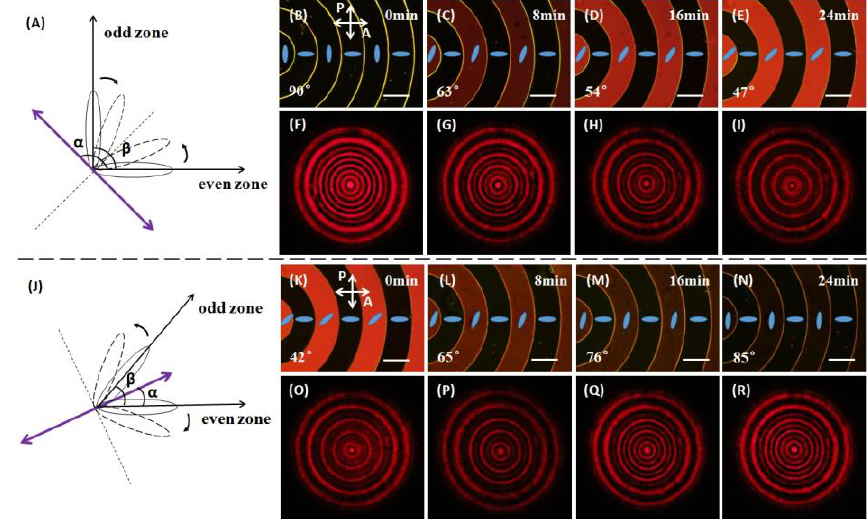
Figure 3. Schematic diagrams of the optical tuning process, and micrographs under polarizing optical microscope (POM) with two crossed polarizers and diffraction patterns of the LC CDG obtained with the polarization of the incident light along the orientation of the LC molecules in the even zones. Line scales represent 200 μm. ( A ) Optical tuning process for reducing the angle β . ( B – E ) Micrographs with the angle β decreasing from 90° to 47° as the exposure time increases. ( F – I ) The corresponding far-field diffraction patterns with the even diffraction orders, except for the eighth order, fading away. ( J ) Optical tuning process for enlarging the angle β . ( K – N ) Micrographs with the angle β increasing from 42° to 85° as the exposure time increases. ( O – R ) The corresponding far-field diffraction patterns with the even diffraction orders, except for the eighth order, fading in.